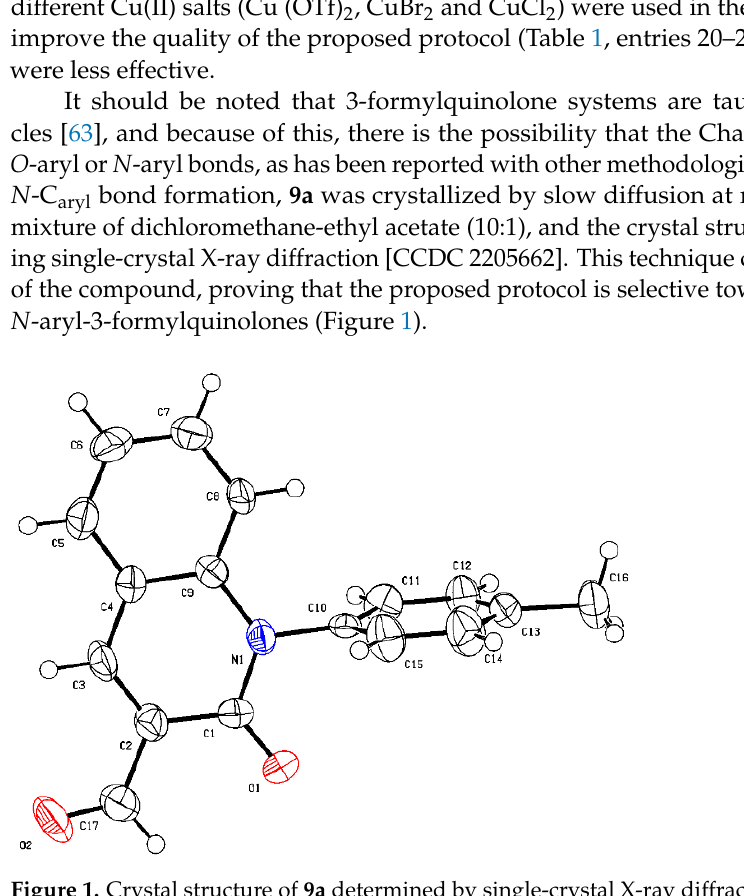
Figure 1. Crystal structure of 9a determined by single-crystal X-ray diffraction. Table 1. Optimization of the reaction conditions a .